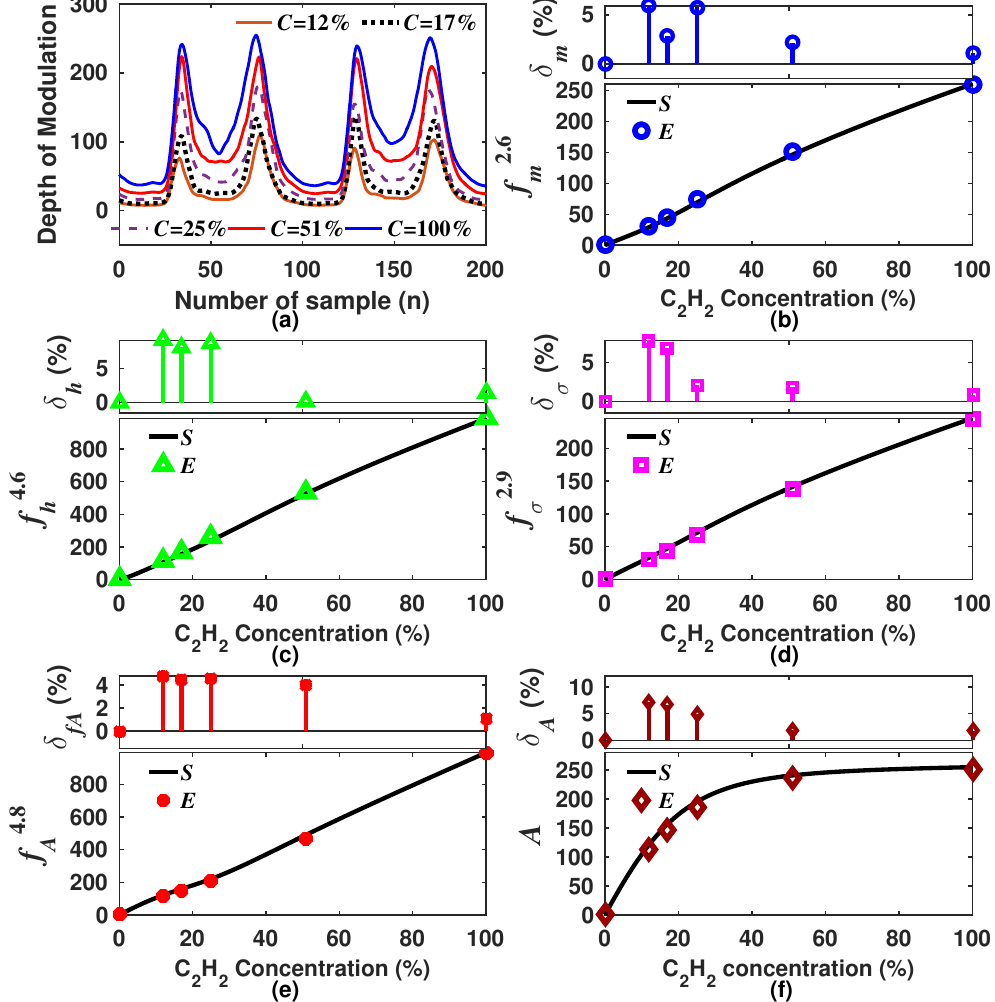
Figure 16. ( a ) Measured sensor output waveforms for different C 2 H 2 concentrations; ( b – f ) simulated ( S ) and calculated statistics features obtained from experimental waveforms ( E